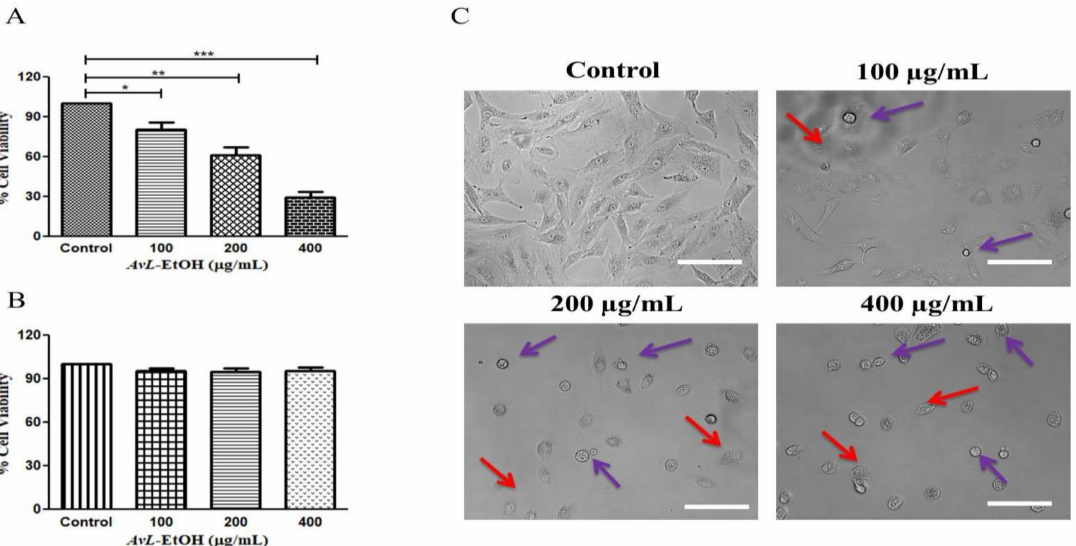
Figure 2. Effect of AvL -EtOH at different concentrations (100, 200 and 400 µ g/mL) against ( A ) A549 cells. ( B ) Insignificant cytotoxic effects of AvL -EtOH against normal human lung fibroblast WI38 cells ( C ) Morphological alterations within A549 cells post treatment with AvL -EtOH. * p < 0.05, ** p < 0.01 and *** p < 0.001. Scale bar= 100 µ m.